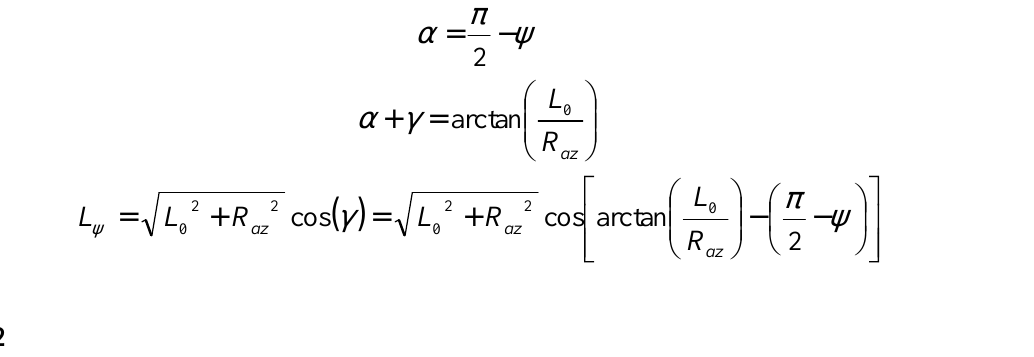
Figure 25. Effects of the yaw angle on the interferometric